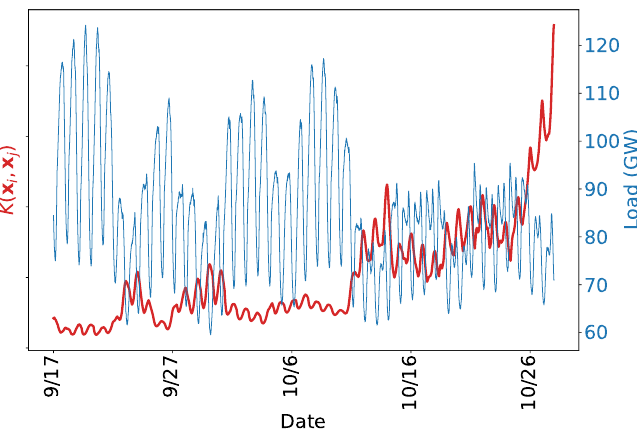
Figure 13. Values for the first row of K ( X new , X ) .